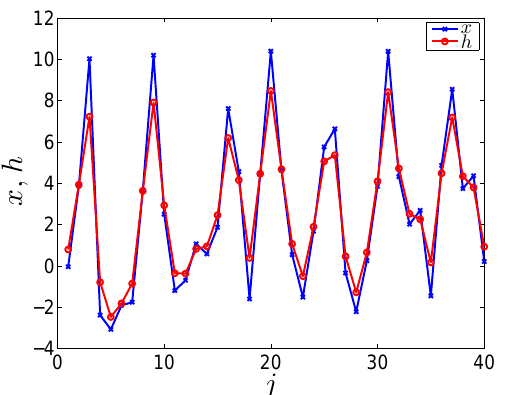
Fig. 1. Typical balanced fields x (blue) and h (red) for the modified slow-fast Lorenz-96 model (Eqs. 17–18).